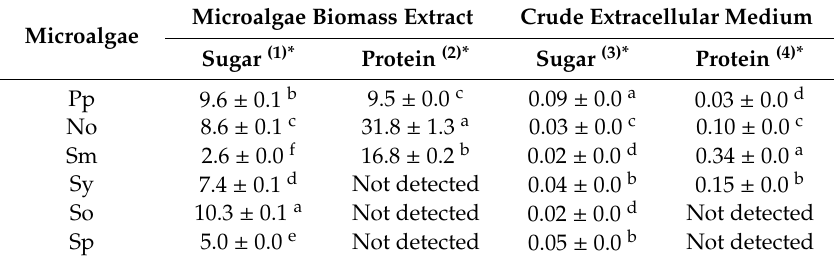
Table 1. Sugar and protein contents in the microalgae biomass extract and the crude extracellular